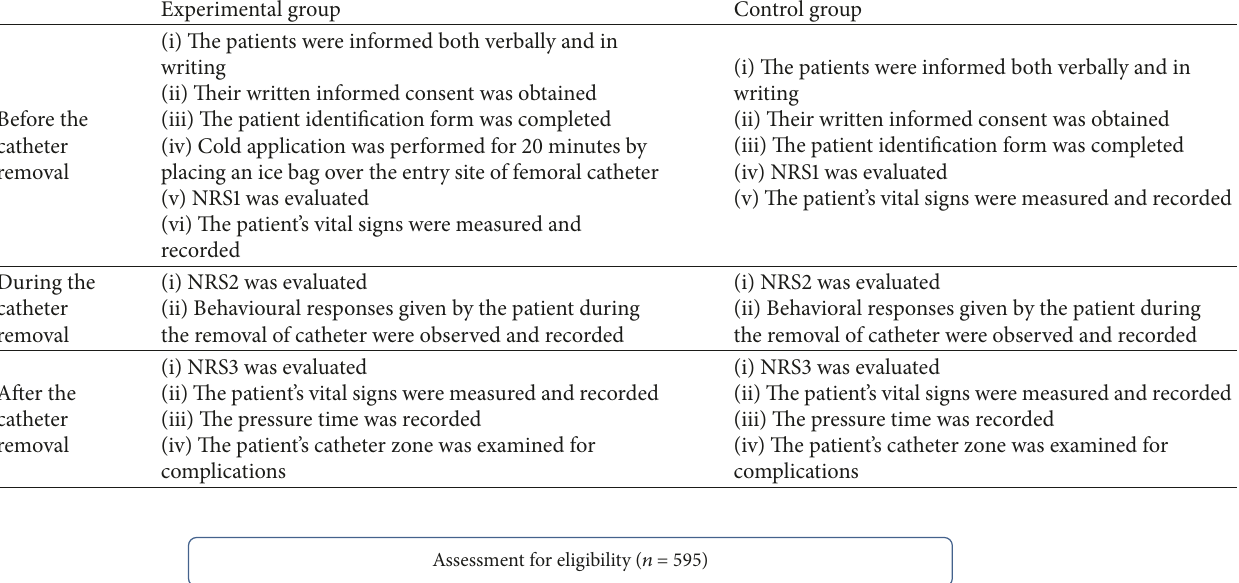
Table 1: Applications to the patients in the experimental and control groups.